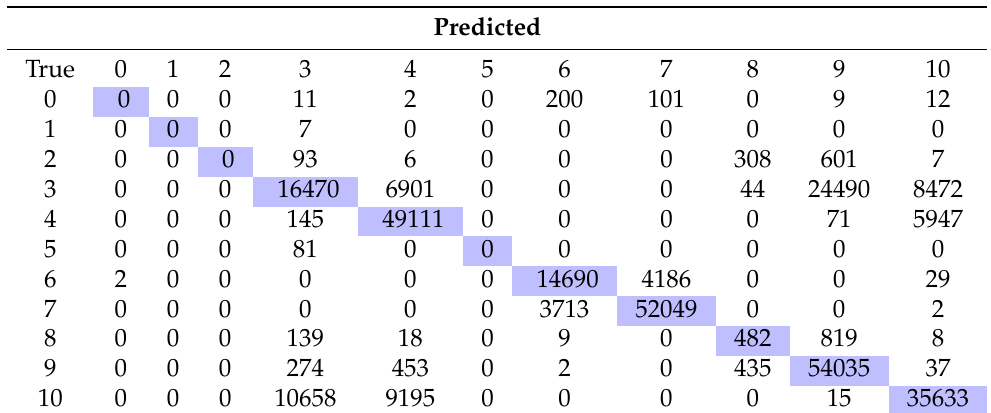
Table 52. LR confusion matrix.